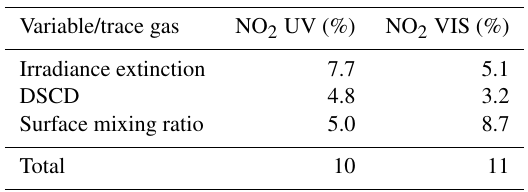
Table 3. Summary of average uncertainties of the retrieval in both spectral